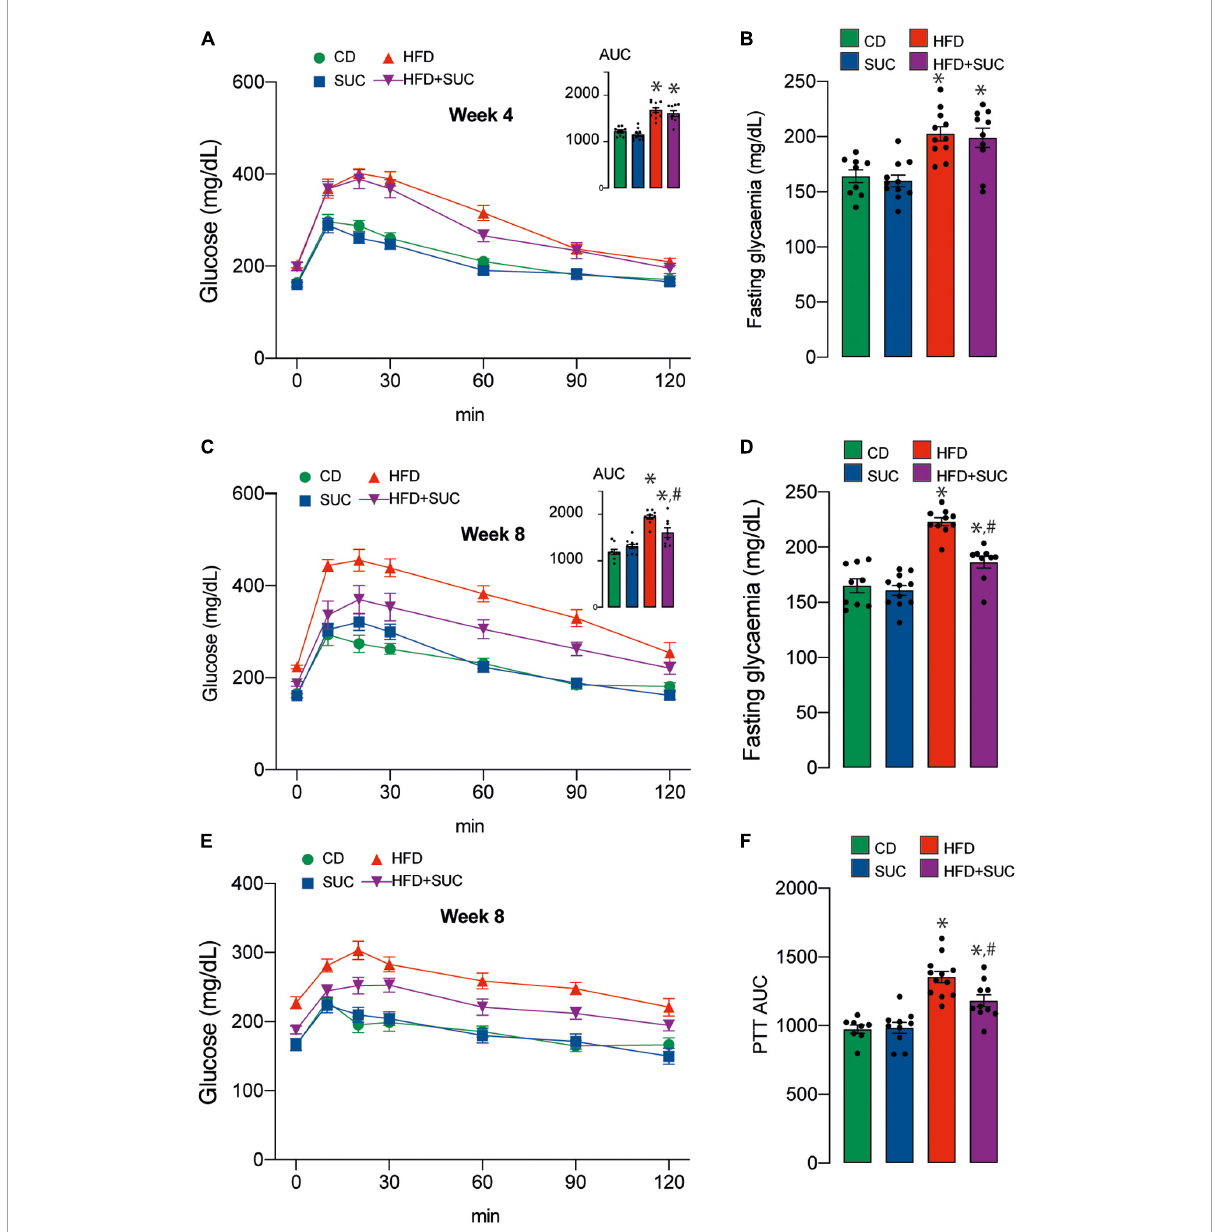
FIGURE2 Sucralose improves glucose tolerance in mice fed with a high-fat diet. (A) GTT at 4 weeks. (B) Basal glucose. (C) GTT at 8 weeks. (D) Basal glucose. (E) PTT. (F) PTT AUC. n = 8–12 mice per condition. Two-way analysis of variance (ANOVA) followed by Holm-Sidak’s post-hoc test. Values are expressed as mean ± SEM. * p < 0.05 vs. CD; # p < 0.05 vs.